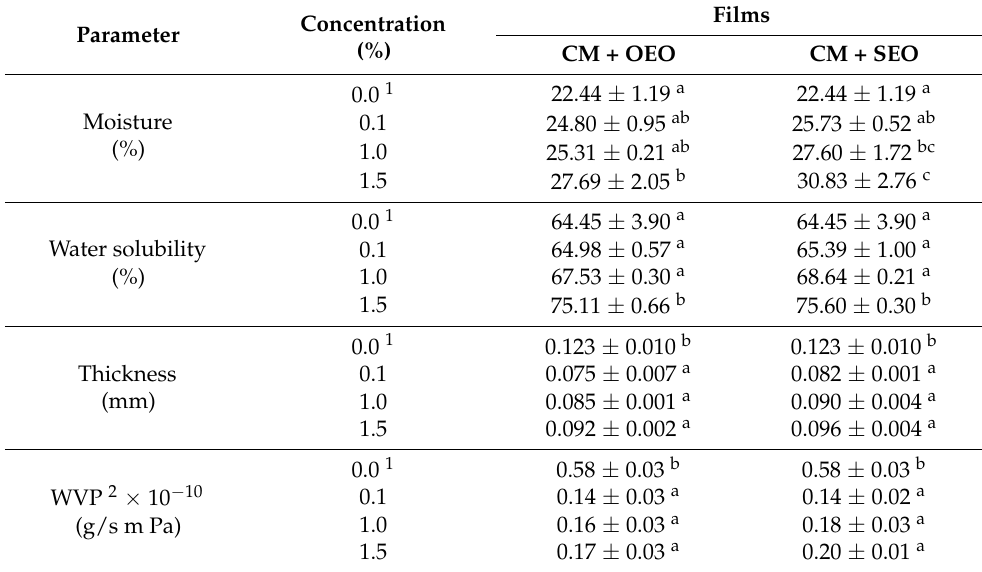
Table 1. Effect of oregano (OEO) or savory (SEO) essential oil addition in the physical properties of the chia mucilage films (CM) (mean ±